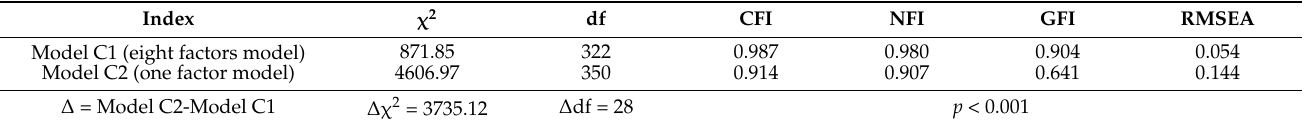
Table 4. The CFA model